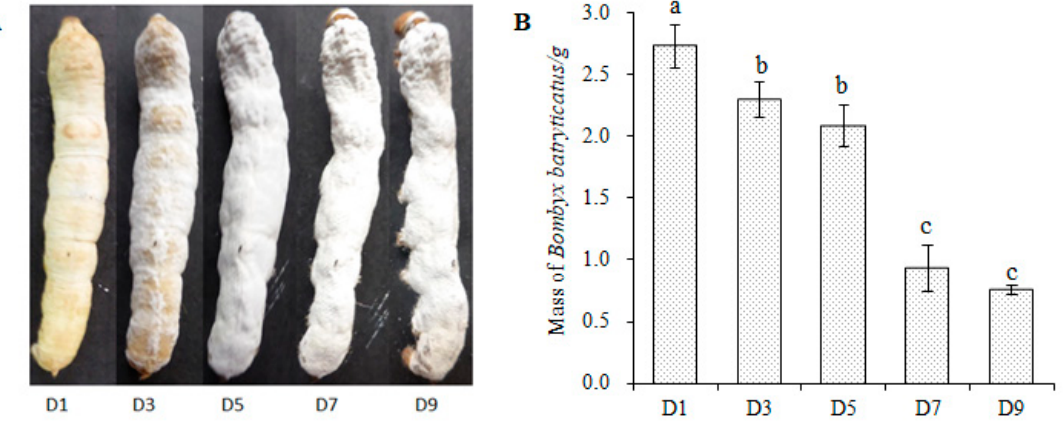
Figure 2. Changes in B. batryticatus during the stiff stage. ( A ) Appearance changes. D1, D3, D5 and D9 indicate 1, 3, 5 and 9 days after B. batryticatus death; ( B ) mass changes. The statistical data were treated by ANOVA and Student-Newman-Keuls (S-N-K) test. Different letters refer to the significant differences ( p < 0.05).